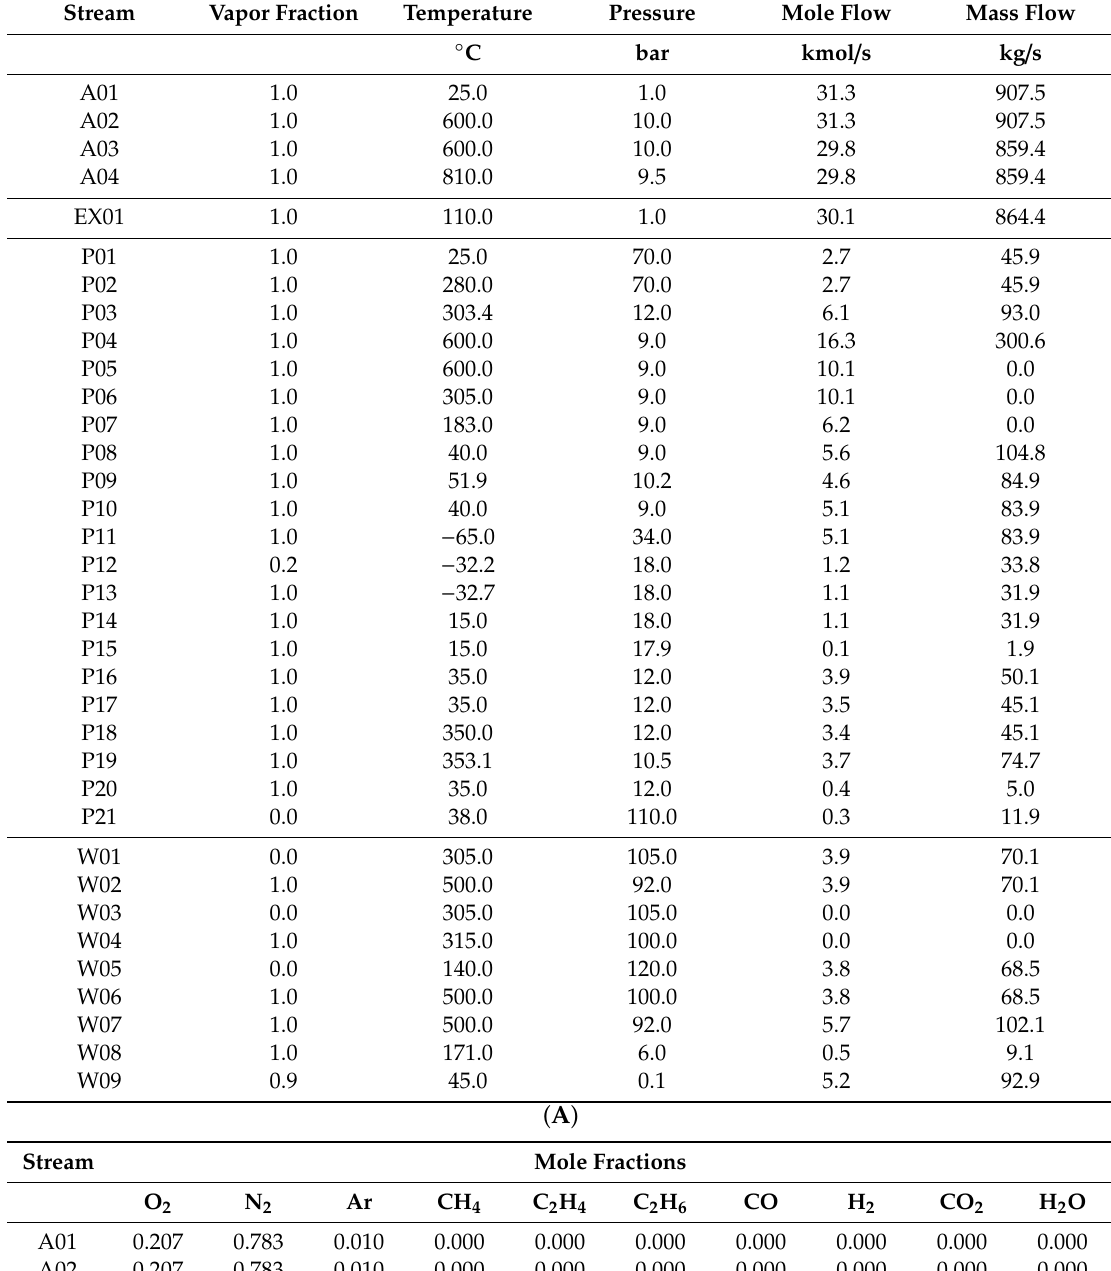
Table A1. OPTIMAL DENSE MEMBRANES